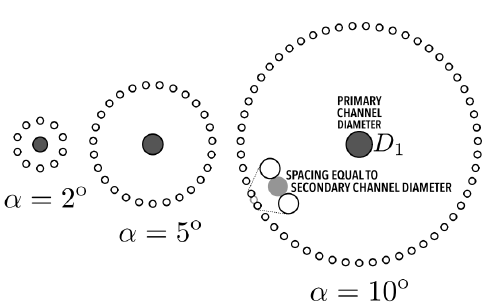
Figure 2. Schematic example of the umbrella geometry.